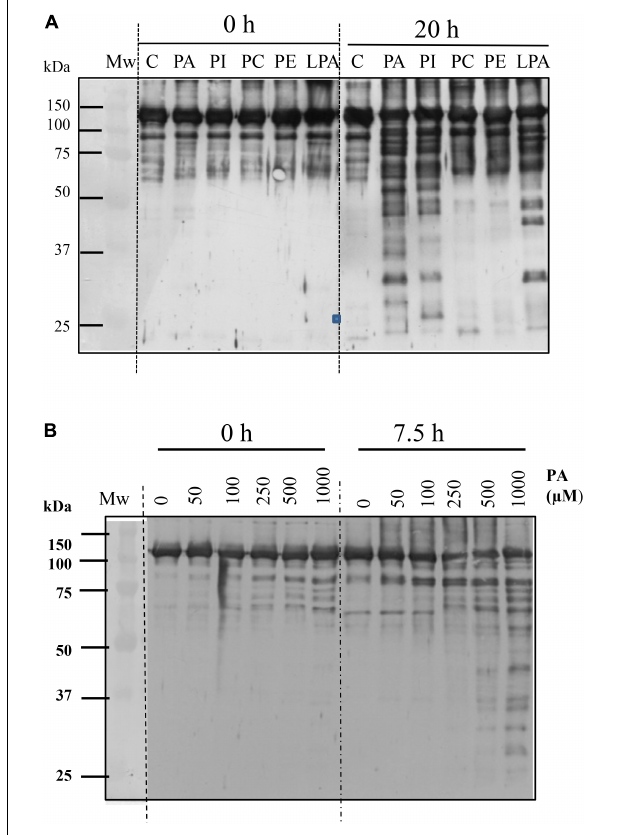
FIGURE 4 | Anionic phospholipids promote proteolysis of C 4 -PEPC. (A) Sp-PEPC was incubated in the absence (lane C) or in the presence of 0.25 mM of the different phospholipids (lanes PA, PI, PC, PE, LPA) at 30 ◦ C as is described in M&M. (B) Range of PA concentration promoting PEPC proteolysis. A standard proteolytic assay was performed with increasing concentrations of PA18:1. At the indicated times, 0.05 U PEPC aliquots were removed and subjected to immunoblot. Bands were detected with PEPC-IgG.